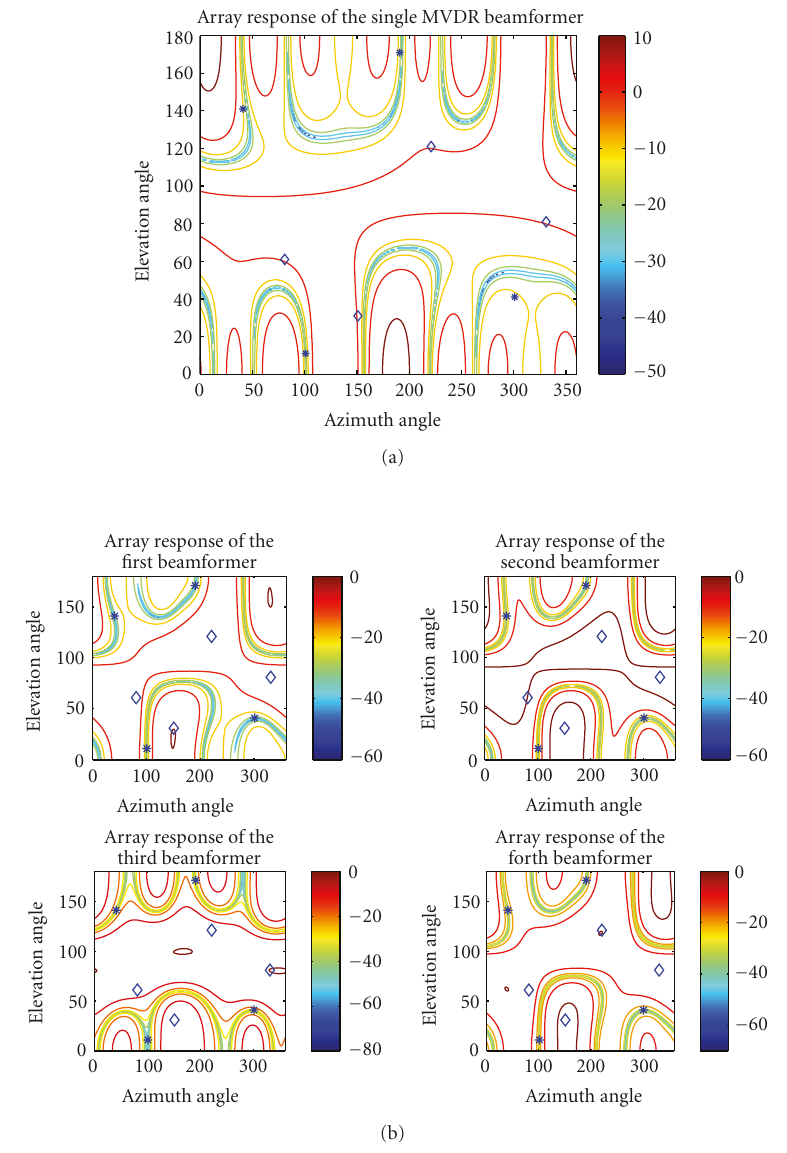
Figure 3: (a) Array response of the single-adaptive MVDR beamformer with four RHCP jammers. (b) Array response of the adaptive multiple MVDR beamformers with four RHCP jammers.